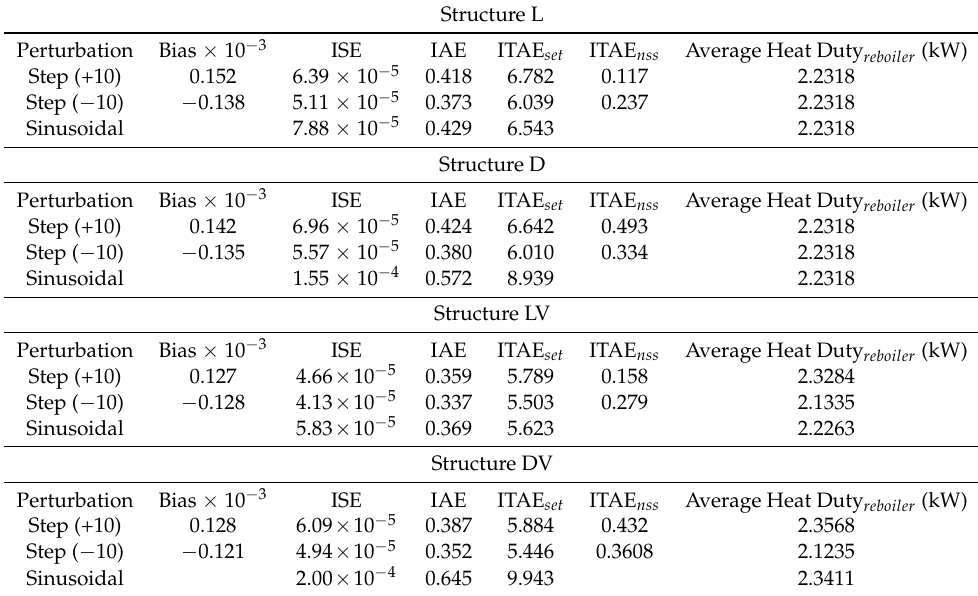
Table 12. Summary of the error indices of the control structures before the disturbances in the composition of the main